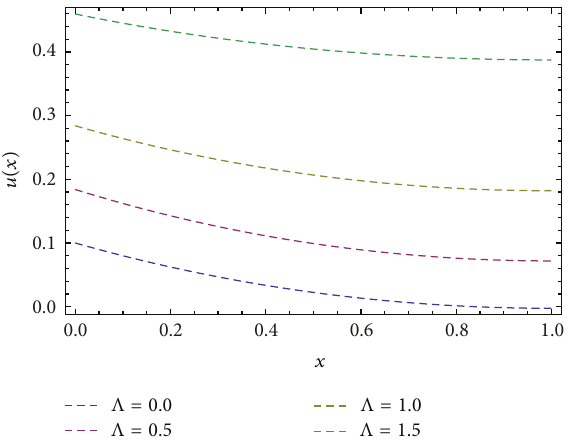
Figure 8: Variation of velocity for various values of slip parameter Λ , by fixing 𝛼 = 0.1 ; 𝑚 = 0.2 ; 𝛽 = 1.2 ; 𝑀 = 0.6 .